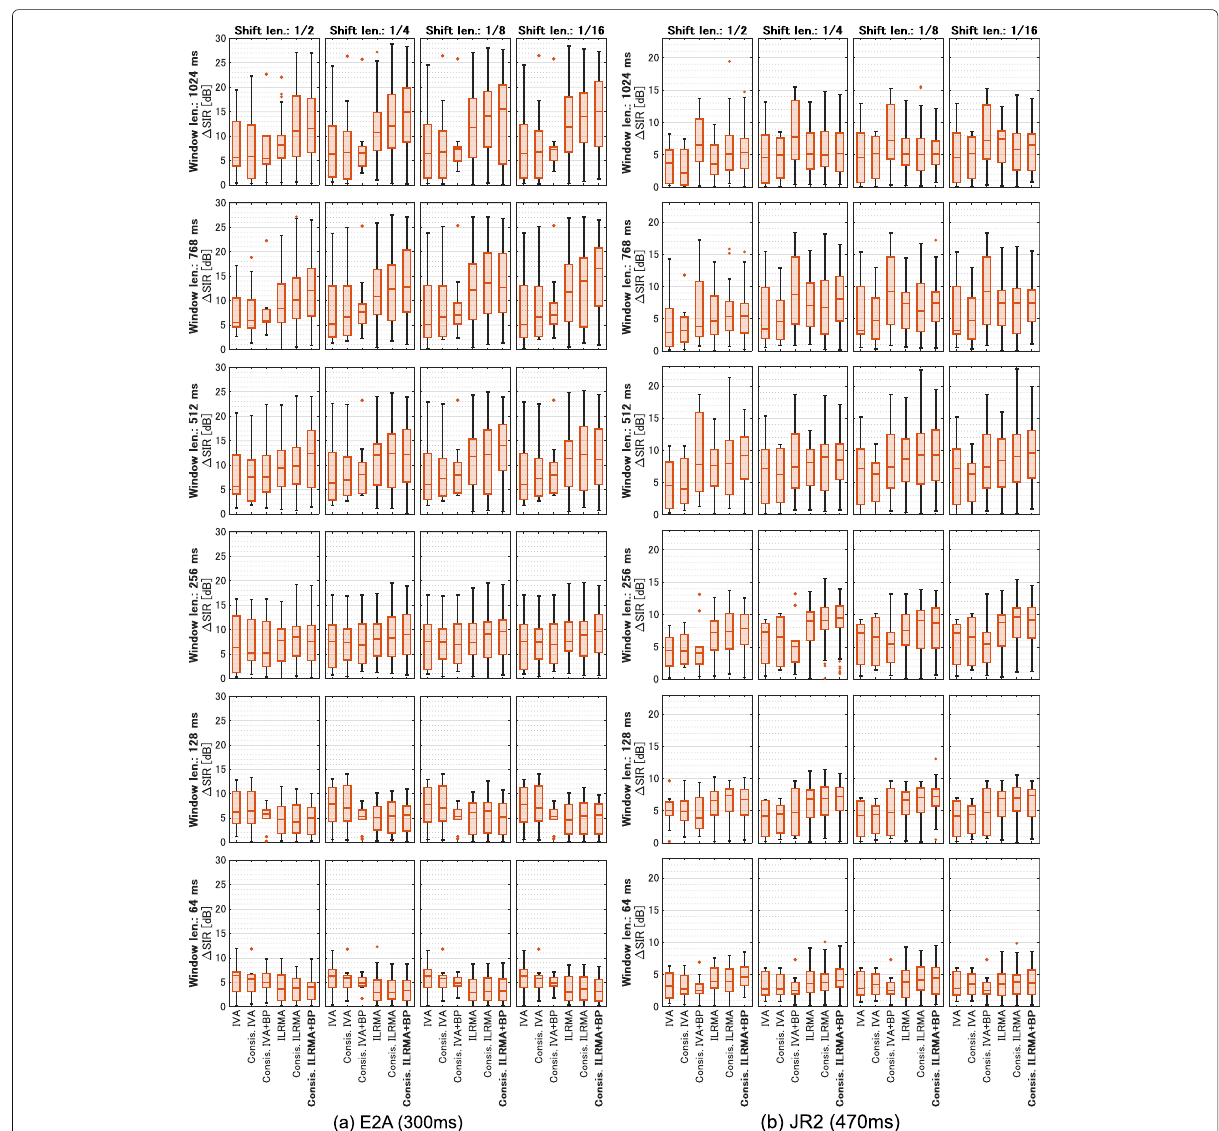
Fig. 19 Average SIR improvements for synthesized speech mixtures (speech 1–10) with a E2A and b JR2 , where Hann window is used in